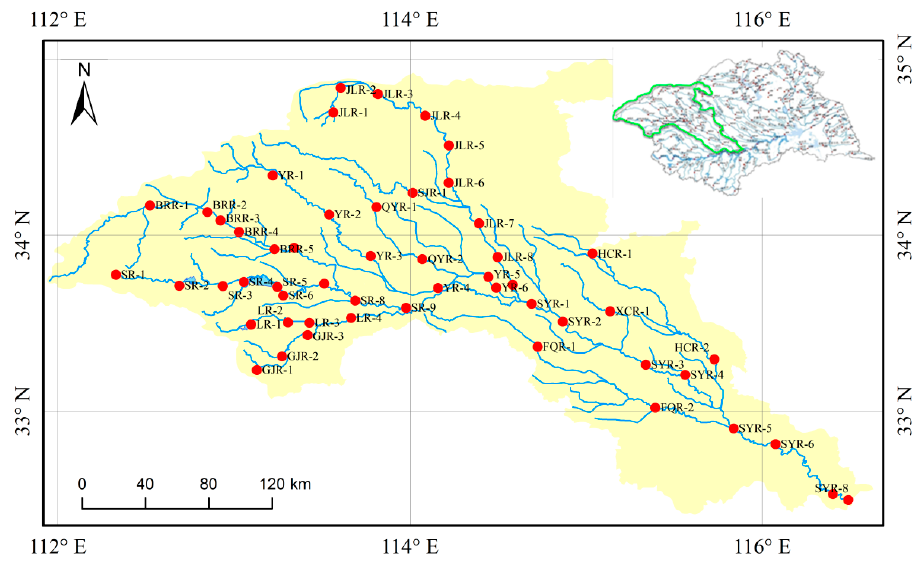
Figure 1. Locations of sampling sites in the Ying River, the largest tributary of the Huaihe River in Eastern China.